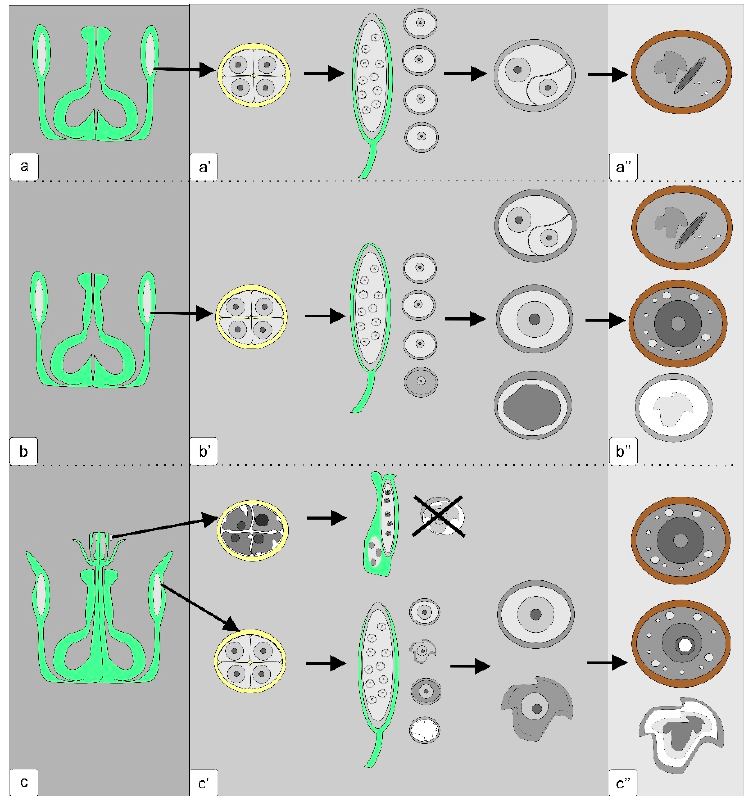
Figure 11. Microsporogenesis pattern in anthers of normal tomato plants ( a , a’ , a’’ ), transgenic plants without phenotypic abnormalities ( b , b’ , b’’ ) and transgenic plants with abnormalities in the generative organs ( c , c’ , c’’ ). The dark gray panel is a scheme of the generative organs of the flower; gray panel—the development of microspores from the exit from tetrad to the stage of asymmetric mitosis; light gray panel—the stage of mature pollen.